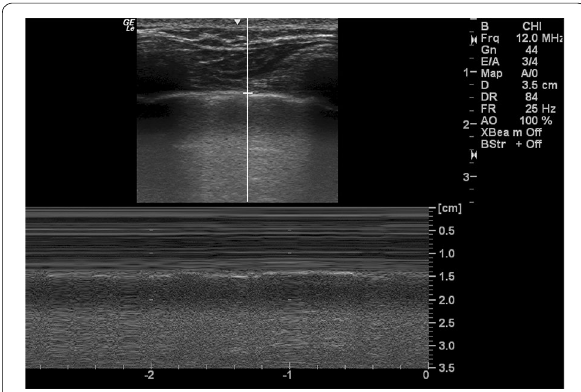
Fig. 4 Parasternal view of the lungs in M‑mode showing sea shore appearance that confirms absence of